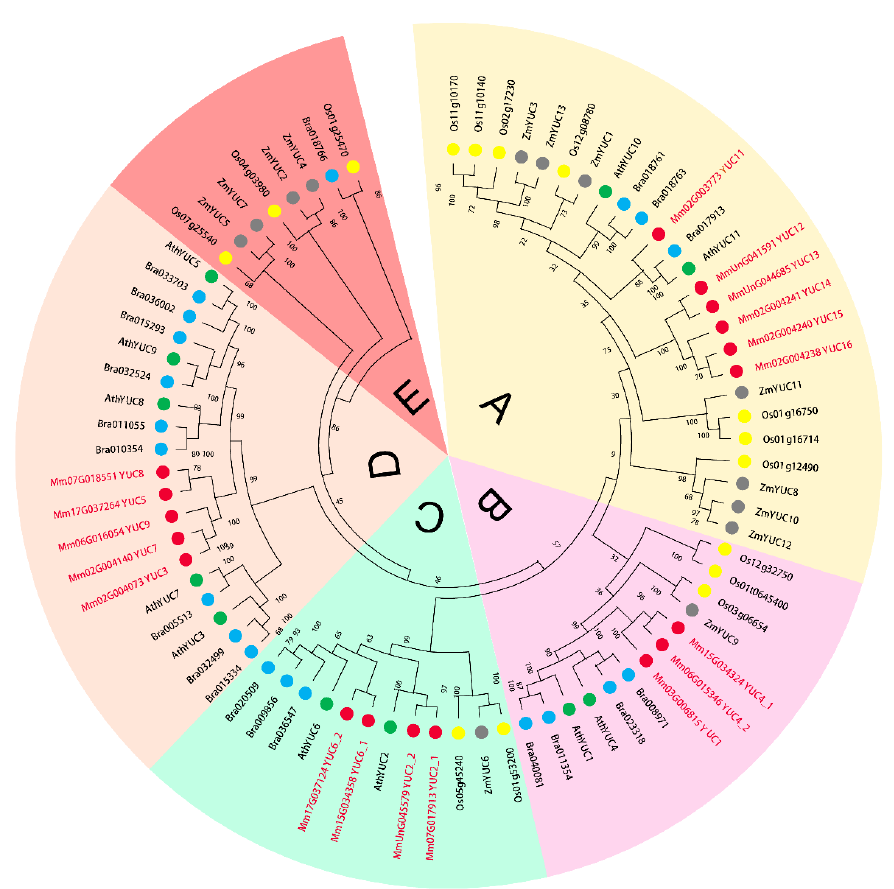
Figure 2. Phylogenetic relationships of YUC genes among Arabisopsis thaliana (green), Oryza sativa (yellow), Brassica rapa (blue), Zea mays (grey) and M. micrantha (red).